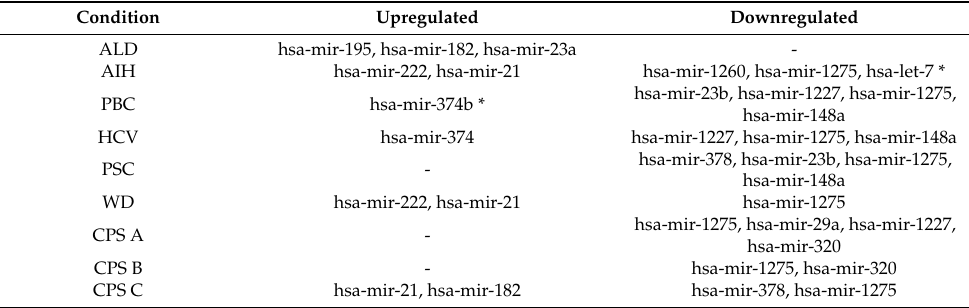
Table 4. Summary of deregulated key DEMs with maximum degree, betweenness centrality, and closeness centrality identified in different conditions of liver disease.